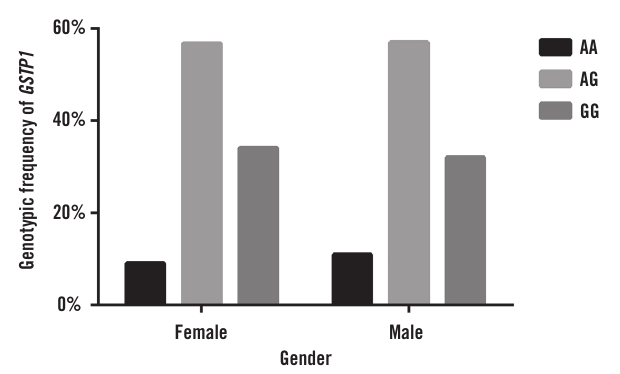
FigurE 1 − Genotype distribution of GSTP1 polymorphism in relation to gender. Chi-square test p = 0.8674